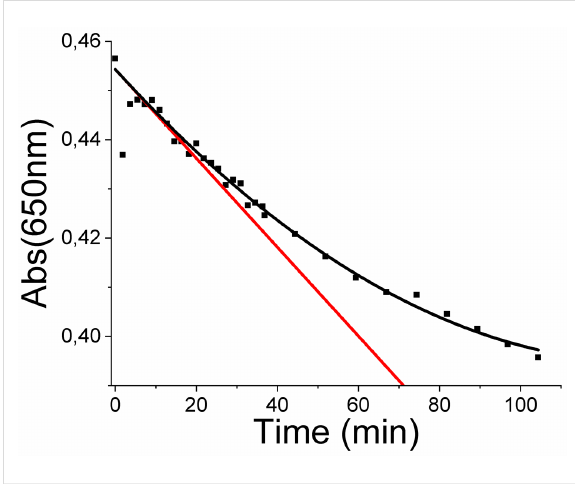
Figure 3: Kinetic trace at 650 nm under CW 976 nm laser at 4.71 W. Initial slope (red line) was determined on the 2nd order polynomial fit of experimental points (dark